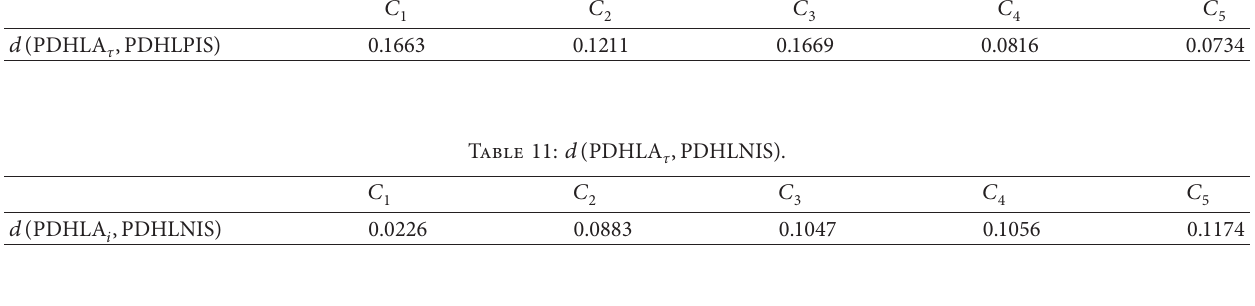
Table 10: d ( PDHLA